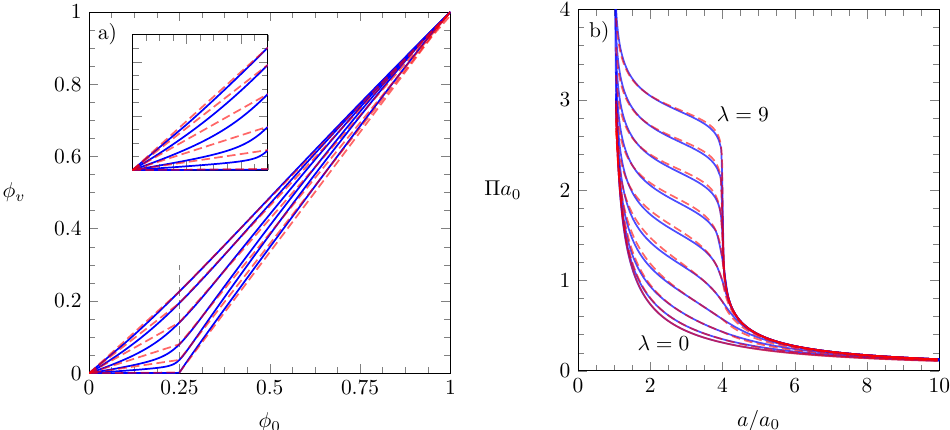
Figure 4. The blue lines in both diagrams re-plot the blue lines already shown in Figure 3. In addition, the dashed red lines show the piece-wise linear approximation for φ v ( φ 0 ) in Equation (28) (diagram a ) and the corresponding scaled lateral pressure a 0 Π (diagram b ). The inset in diagram a is a magnified view of the region 0 ≤ φ 0 ≤ 0.25. As in Figure 3, all results are derived for ξ = 4. The corresponding lateral pressure obtained by inserting φ v ( φ 0 ) according to Equation (28) into Equation (22) is shown in the right diagram of Figure 4 by the red dashed